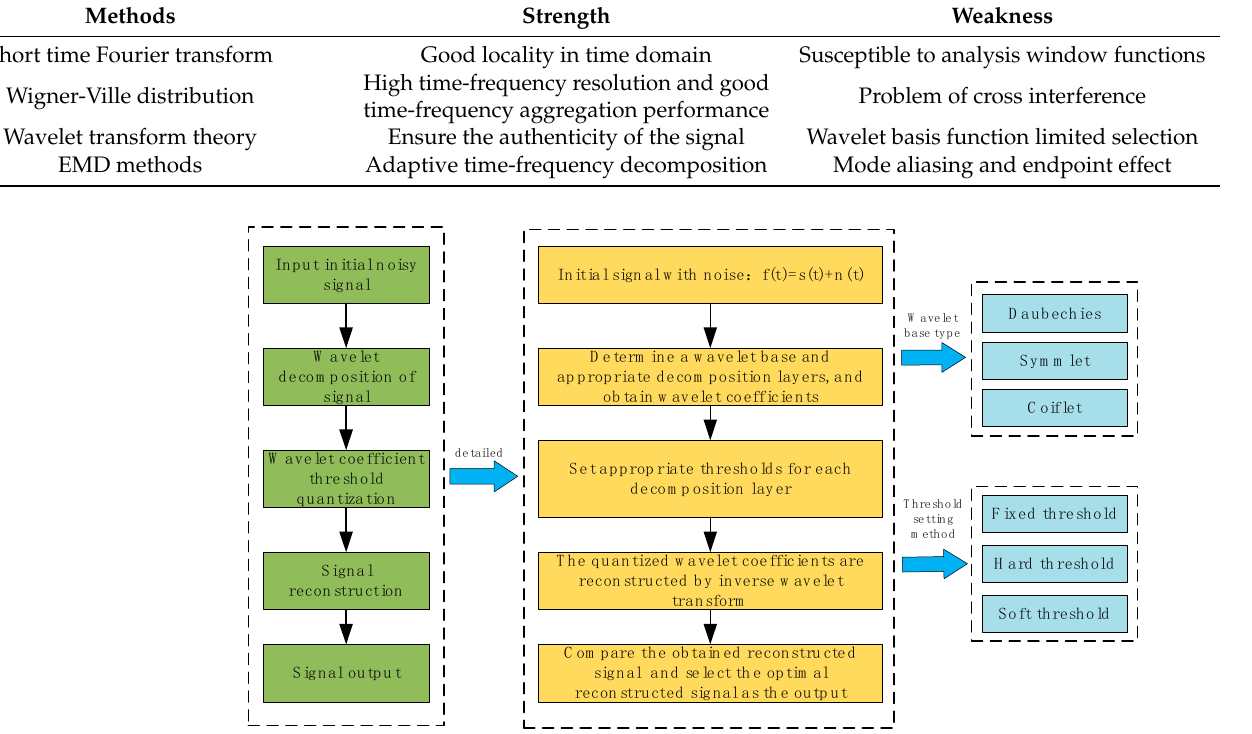
Table 1. Comparison of time-frequency domain signal processing technology.